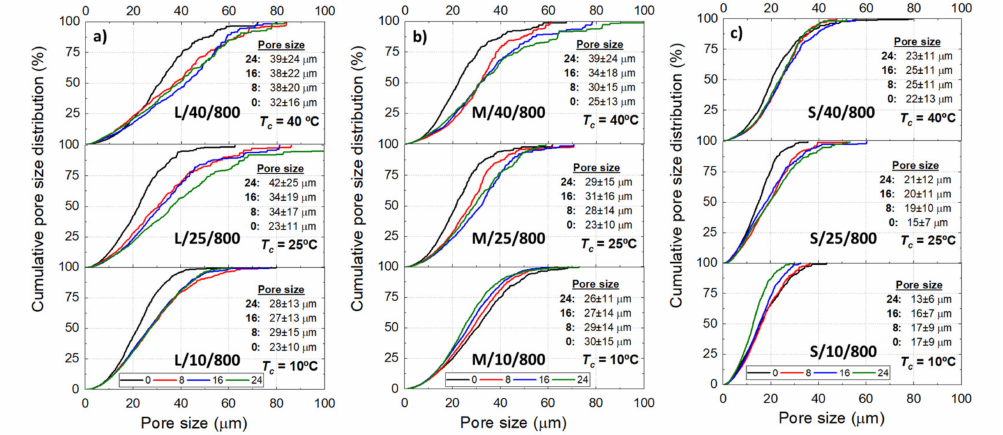
Figure 4. Cumulative pore size distribution of the Ni wick sintered at 800 °C according to the initial sample height ( h = 0, 8, 16, and 24 mm), freezing temperature ( T c = 40, 25, and 10 ◦ C), and de particle size range L ( a ), M ( b ), and S ( c ). Tables inserted show the average pore size ( ∅ ) at the respective h